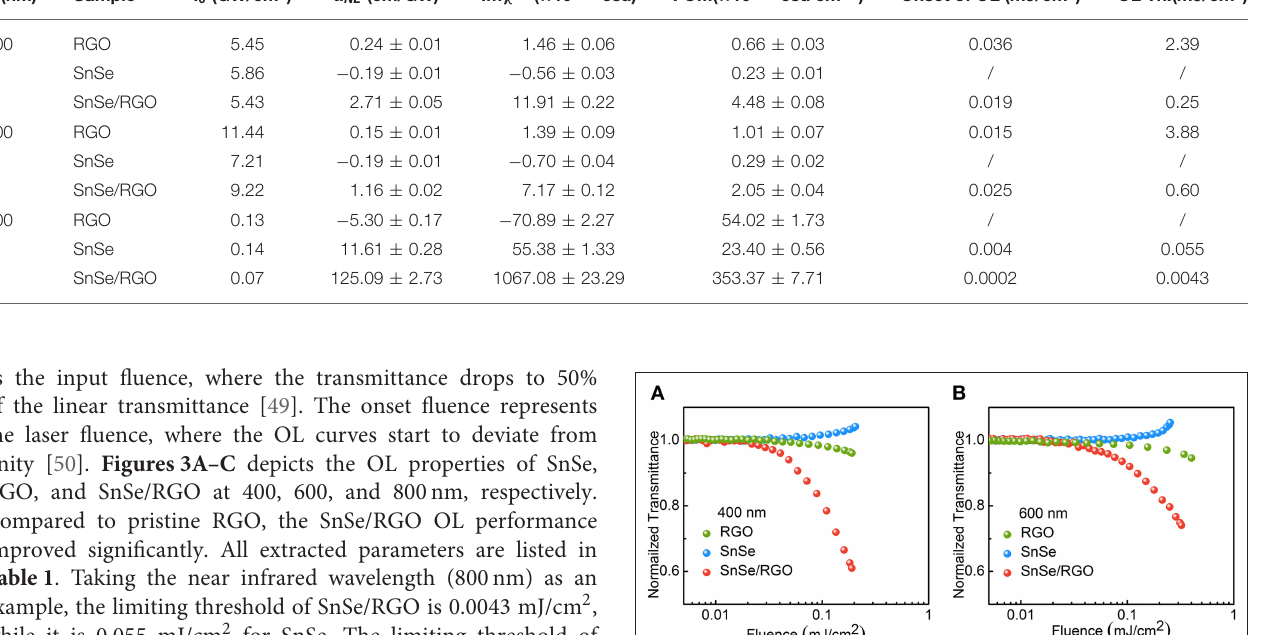
TABLE 1 | NLO parameters and OL parameters of RGO, SnSe, and SnSe/RGO at multi-wavelengths. λ (nm) Sample